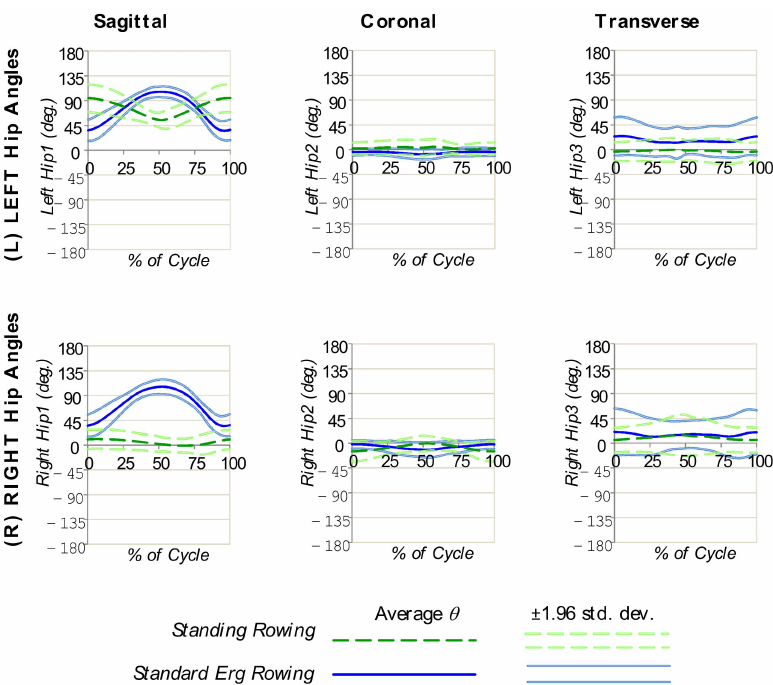
Figure 8. The averaged angular measurements for the hip from the laboratory study, reported as mean ± 1.96 s.d., which compares standing rowing (green) with standard ergometer sliding-seat rowing (blue).